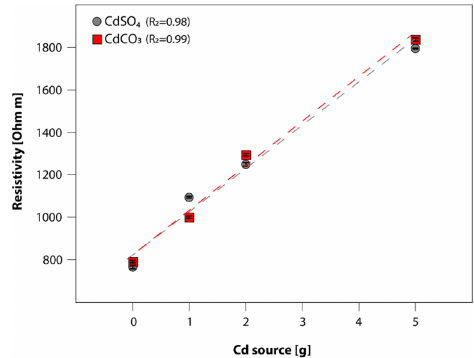
Figure 3. Lineal regression between resistivity values [Ohm.m] and four Cd concentrations [g] amended to controlled experiments during the standardization of the 2D–ERT technique into non-naturally contaminated soil samples. SD is shown as vertical bars.